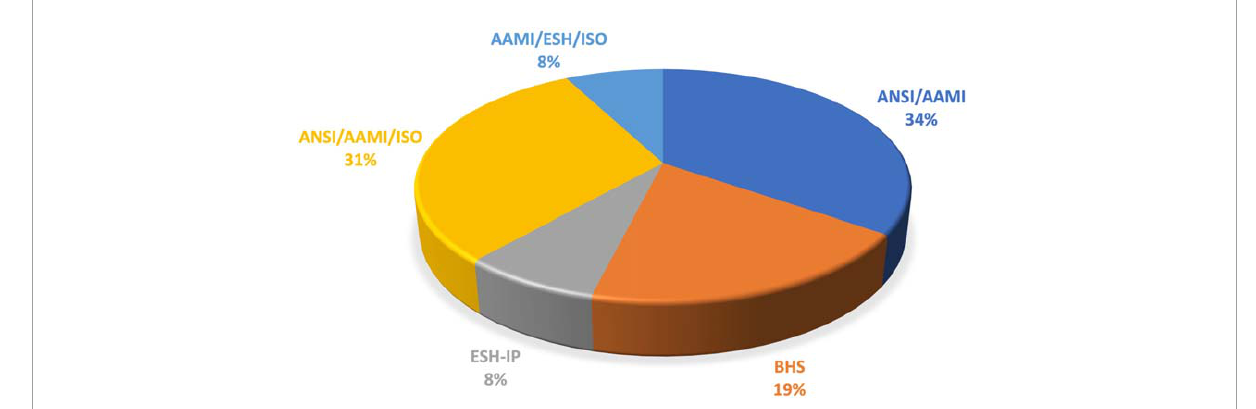
FIGURE1 Validation protocols used in studies assessing accuracy of BP measuring devices in children and